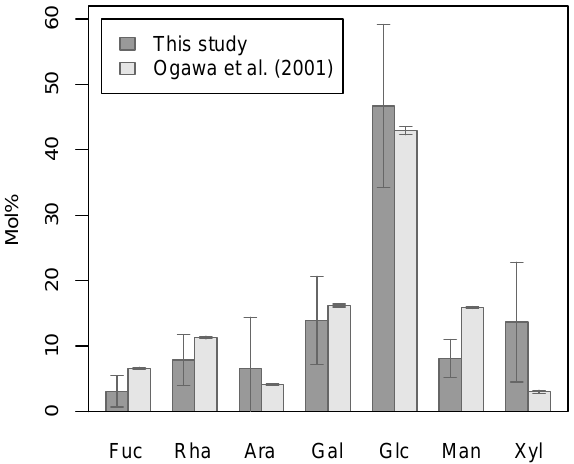
Figure 6. Molecular composition of neutral sugars on day 32 of the incubations. Means and standard deviations were calculated from all samples on day 32 ( n =